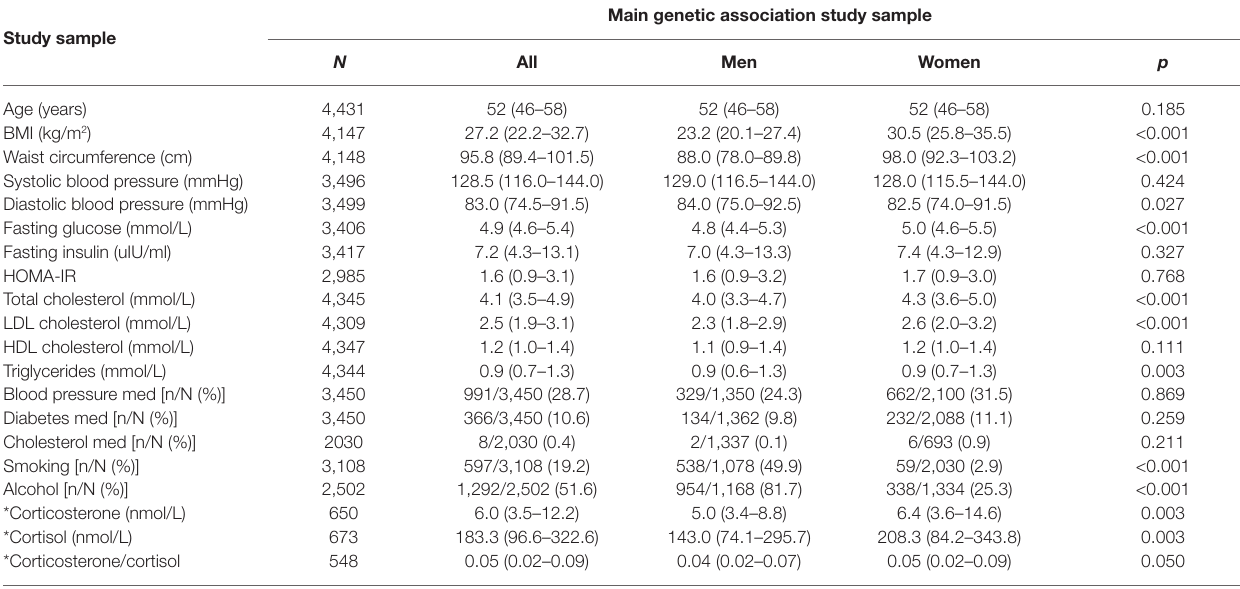
TABLE 1 | Characteristics of the study sample of black South Africans and a comparison between sexes.